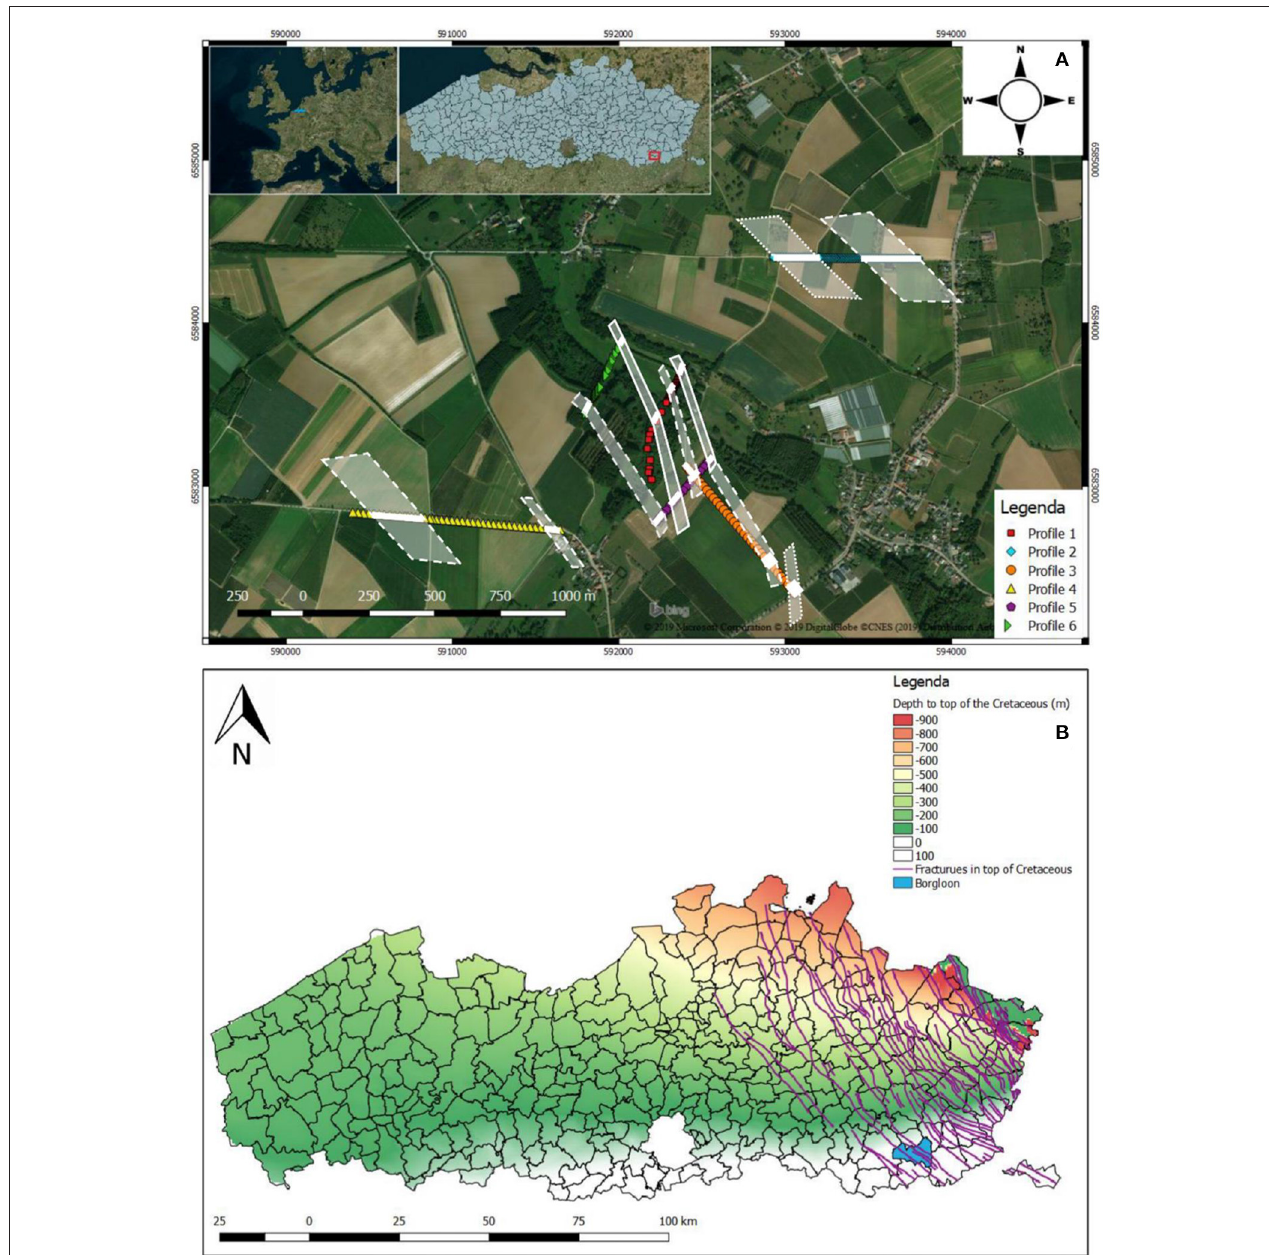
FIGURE 5 | (A) Surface map with indication of identified fractured zones on the six ERT profiles and indication of the possibly linked fractured zones (white dotted line). The full lines are more certain, the dashed lines are less certain, and the dotted lines are the least certain. (B) Fractures in the top Of the Cretaceous in Flanders (purple). The colorscale indicates the depth to the top of the Cretaceous. The municipality of the extraction site is indicated in Blue.